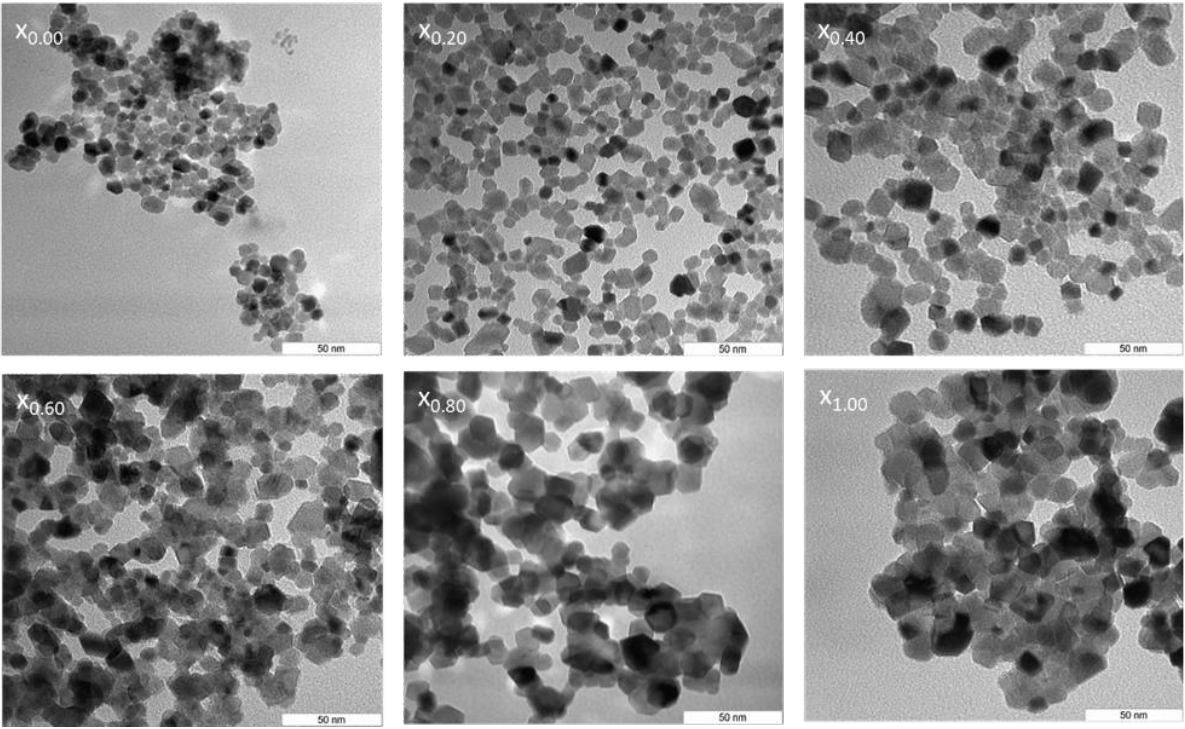
Figure 3. TEM images of (x 0.00 ) Ce 0.00 Sn 1.00 O 2 , (x 0.20 ) Ce 0.20 Sn 0.80 O 2 , (x 0.40 ) Ce 0.40 Sn 0.60 O 2 , (x 0.06 ) Ce 0.60 Sn 0.40 O 2 , (x 0.08 ) Ce 0.80 Sn 0.20 O 2 and (x 1.00 ) Ce 1.00 Sn 0.00 O 2 ) nanoparticles calcined at 650 °C.